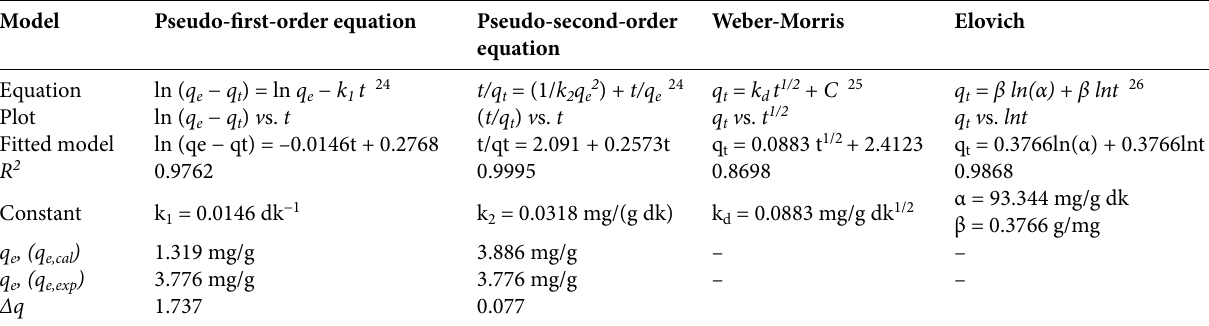
Table 4. Modeling of adsorption